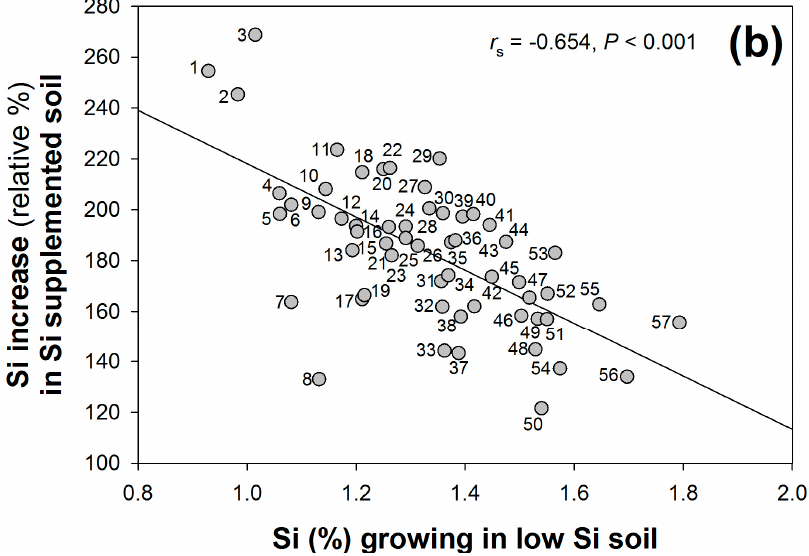
Figure 4. The relationship between shoot Si concentrations when growing in low-Si soil and the ( a ) absolute and ( b ) relative (%) increase in Si accumulation when accessions were grown in high (Si-supplemented) soil. Accessions indicated (1) Gaz2, (2) Adi6, (3) Adi15, (4) Bd23–01, (5) BdTR3a, (6)